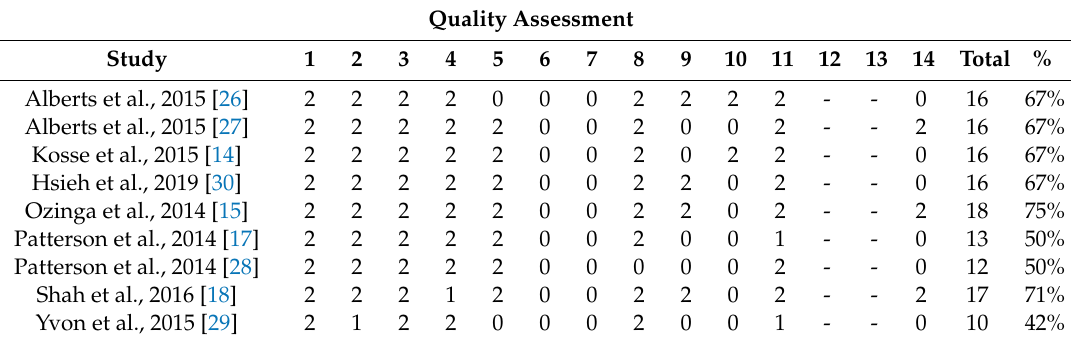
Table A1. Results of the quality assessment tool of the 9 studies (NIH-NHLBI).